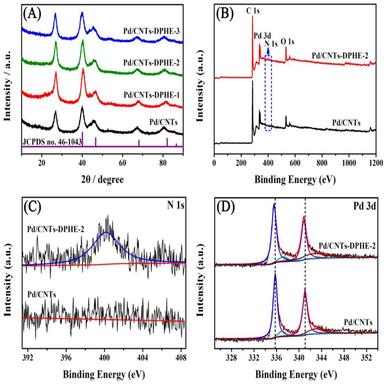
(A) XRD patterns of Pd/CNTs, Pd/CNTs-DPHE-1, Pd/CNTs-DPHE-2 and Pd/CNTs-DPHE-3. XPS survey (B) and high-resolution region of N 1s (C) and Pd 3d (D) for Pd/CNTs and Pd/CNTs-DPHE-2.